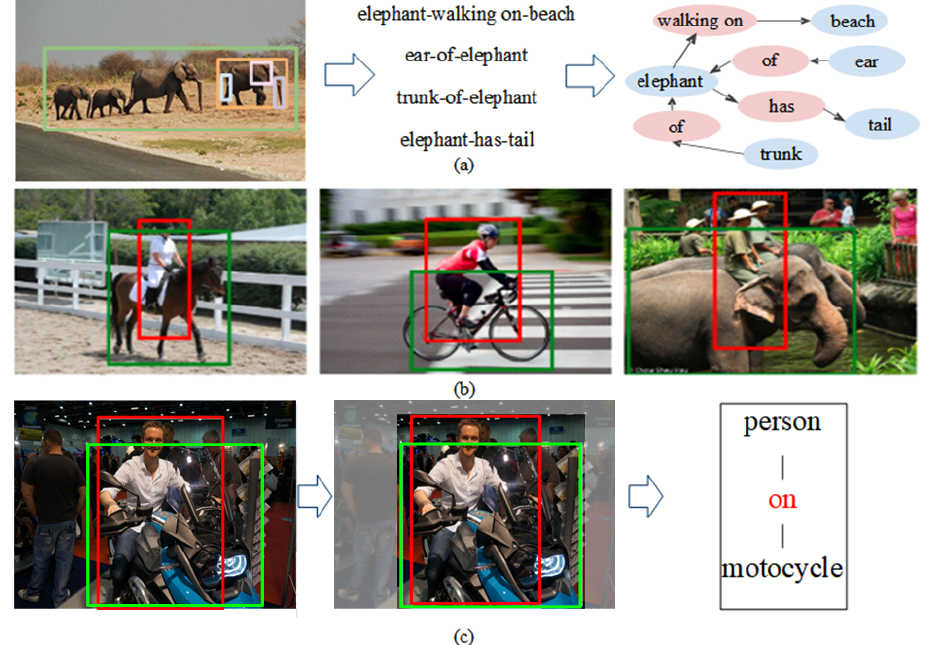
Figure 1. ( a ) An example of an SGG model. ( b ) Different visual representations of similar relationships in the Visual Genome dataset. ( c ) An intuitive example of eliminating visual dependencies caused by external knowledge or visual information bias. It should be noted that the background blurring is applied only for illustration and should not be considered part of the visual processing